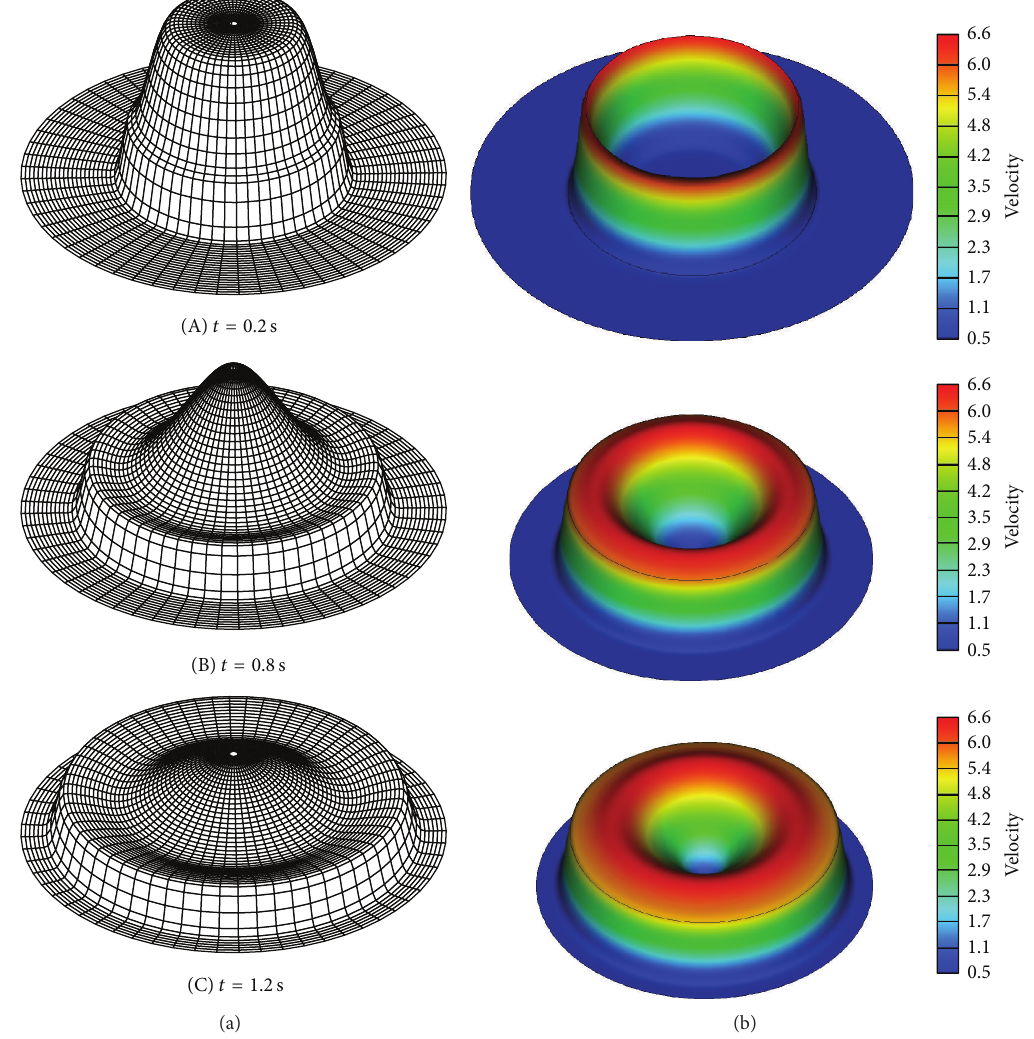
Figure 7: Evolution of water surface (a) and velocity (b) after breaking of the circular cylinder (unit of velocity: